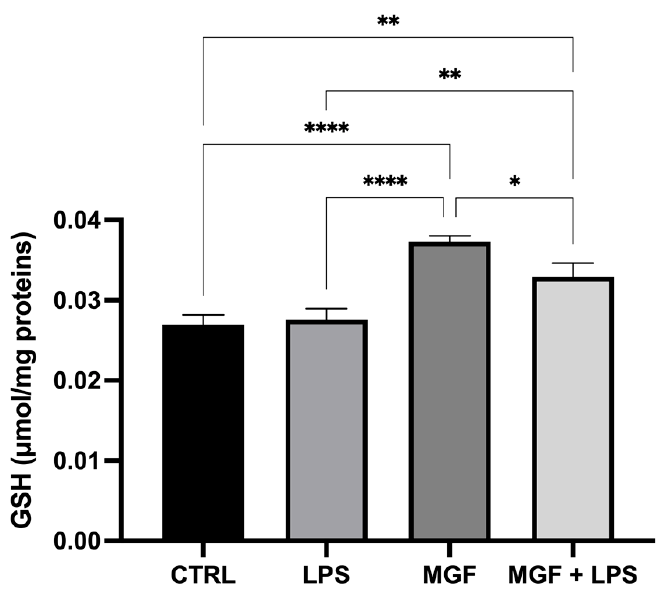
Figure 4. Quantification of intracellular content of reduced GSH analyzed by spectrophotometric assay in NCI-H292 cells. Cells were treated with LPS 10 µ g/mL for 1 h, and with MGF 20 µ g/mL for 24 h. * p < 0.05; ** p < 0.01; **** p < 0.0001.